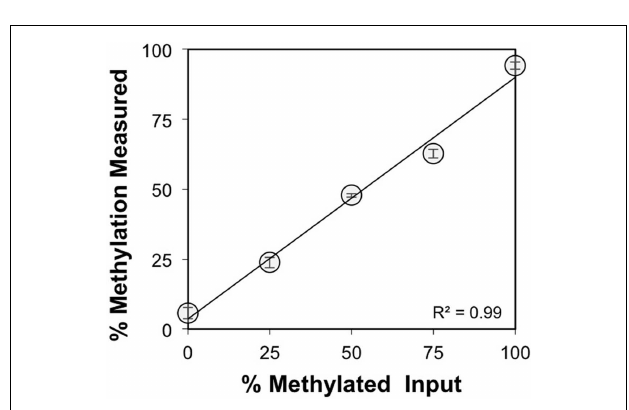
(B) IGF2 expression shown as a bar graph ( + SD for replicate measures; left y axis) as detected in tissues from a 108-day gestation human female conceptus with the corresponding level of methylation, given as a percentage, at the CpG within the intron 3 CTCF binding motif (right y axis, circles ± SD of replicate measures).The data are arranged from left to right in increasing order of IGF2 expression.